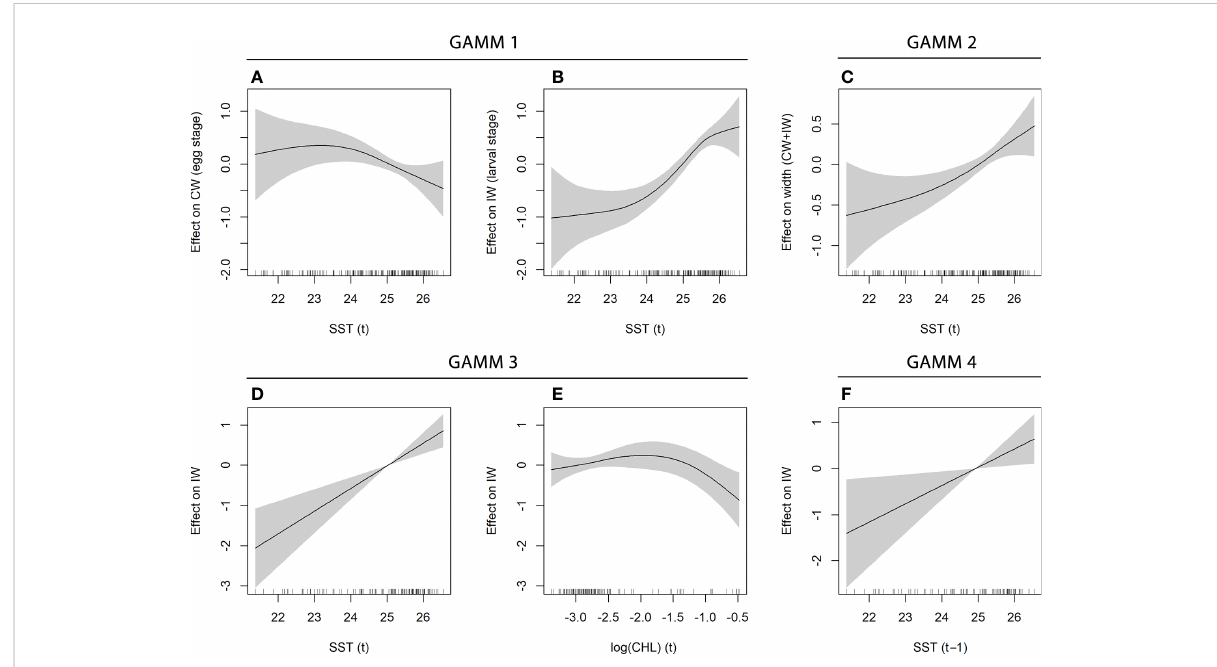
FIGURE 8 Signi fi cant cubic regression smoothers estimated in GAMMs performed on the mean width of otolith increments (IW, response variable) and environmental factors (explanatory variables). Further outcomes are reported in Table 2 (plots for GAMM #5 are not displayed because both covariates were not signi fi cant). In each panel, the grey region de fi nes the con fi dence interval of the estimated smooth term. Vertical ticks over the horizontal axes represent the covariate distribution expressed as a 1-d rug plot.